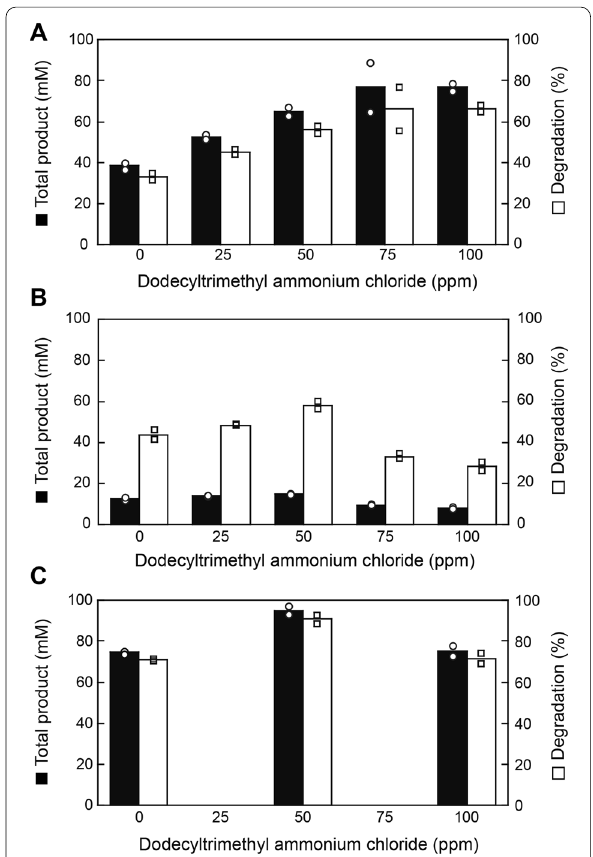
Fig. 4 Effect of surfactant concentrations on amorphous PET film and amorphous PET powder. A Two pieces (6 mm ; 116 μmoles/ ∅ ml as monomer unit) of amorphous PET film (Nonacryl V): B Homogenized PET bottle flakes (28.5 μmoles/ml as monomer unit): C Powder 2 (105 μmoles/ml as monomer unit). The reactions were performed at 63 °C for 3 days in a 1-ml reaction mixture, using Cut190*SS under the standard reaction conditions except that buffer concentration in A (50–100 ppm) (160–310 μM) and C (0–100 ppm) (0–310 μM) was raised to 150 mM. The reactions were performed in duplicate. Variations in values are indicated by open circles for total products and open squares for degradation